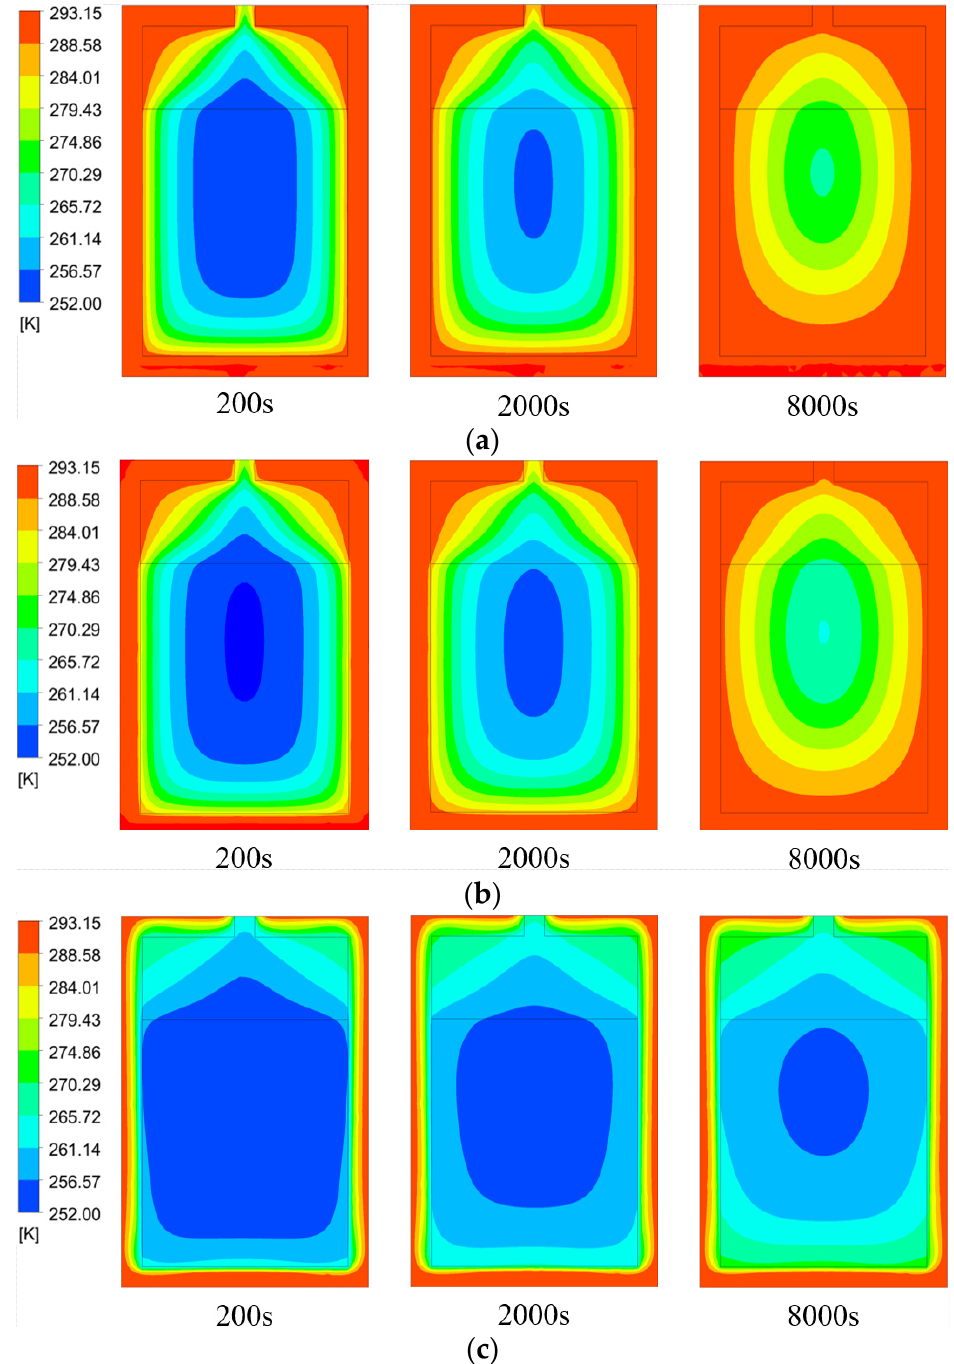
Figure 6. A temperature distribution cloud figure in different times of the reaction tank subjected to different heat transfer media of air, water, and oil: ( a ) water as the heat transfer medium; ( b ) oil as the heat transfer medium; ( c ) air as the heat transfer medium.